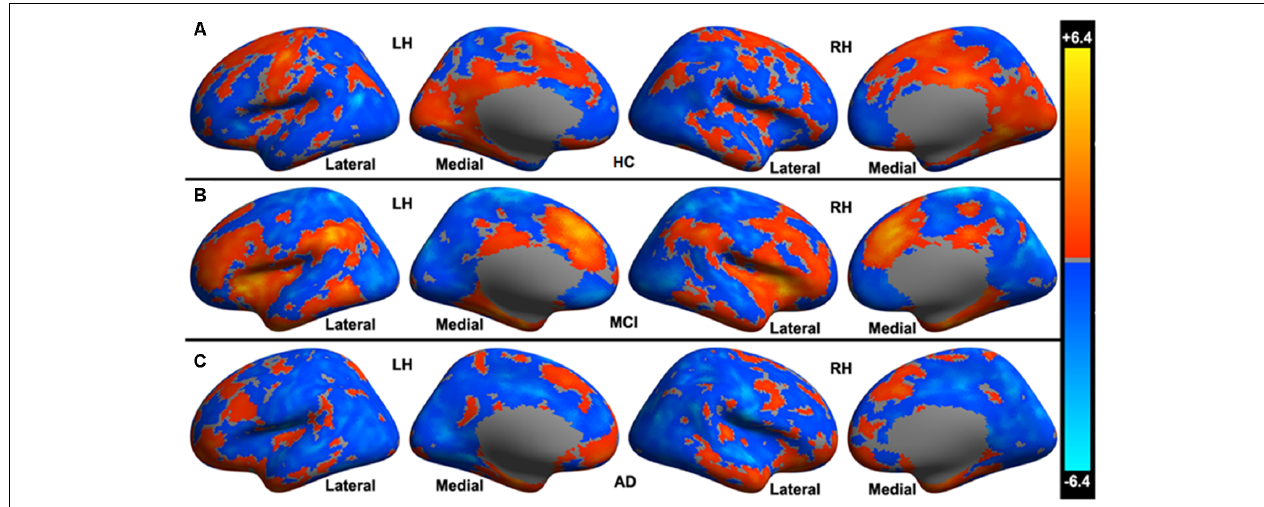
showing functional connectivity to the cerebellar limbic network were nearly symmetrically distributed in bilateral